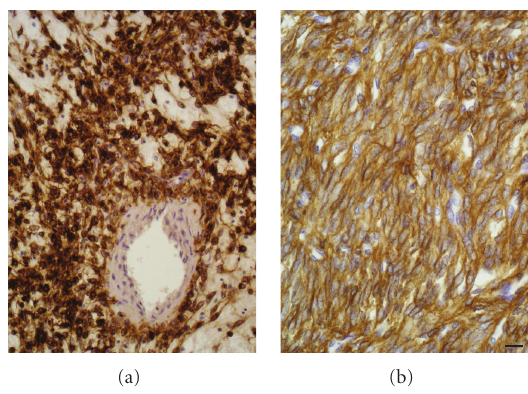
Figure 1: EGFR expression in MPNSTs. In both cases, 100% of tumour cells strongly expressed EGFR (brown). However, it was detected either (a) within the cytoplasm or (b) on plasma membrane. Cell nuclei were stained in blue by hematoxylin. Scale bar represent 20 µ m.